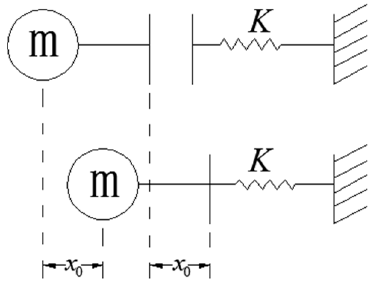
Figure 1. Linear spring-gap element.